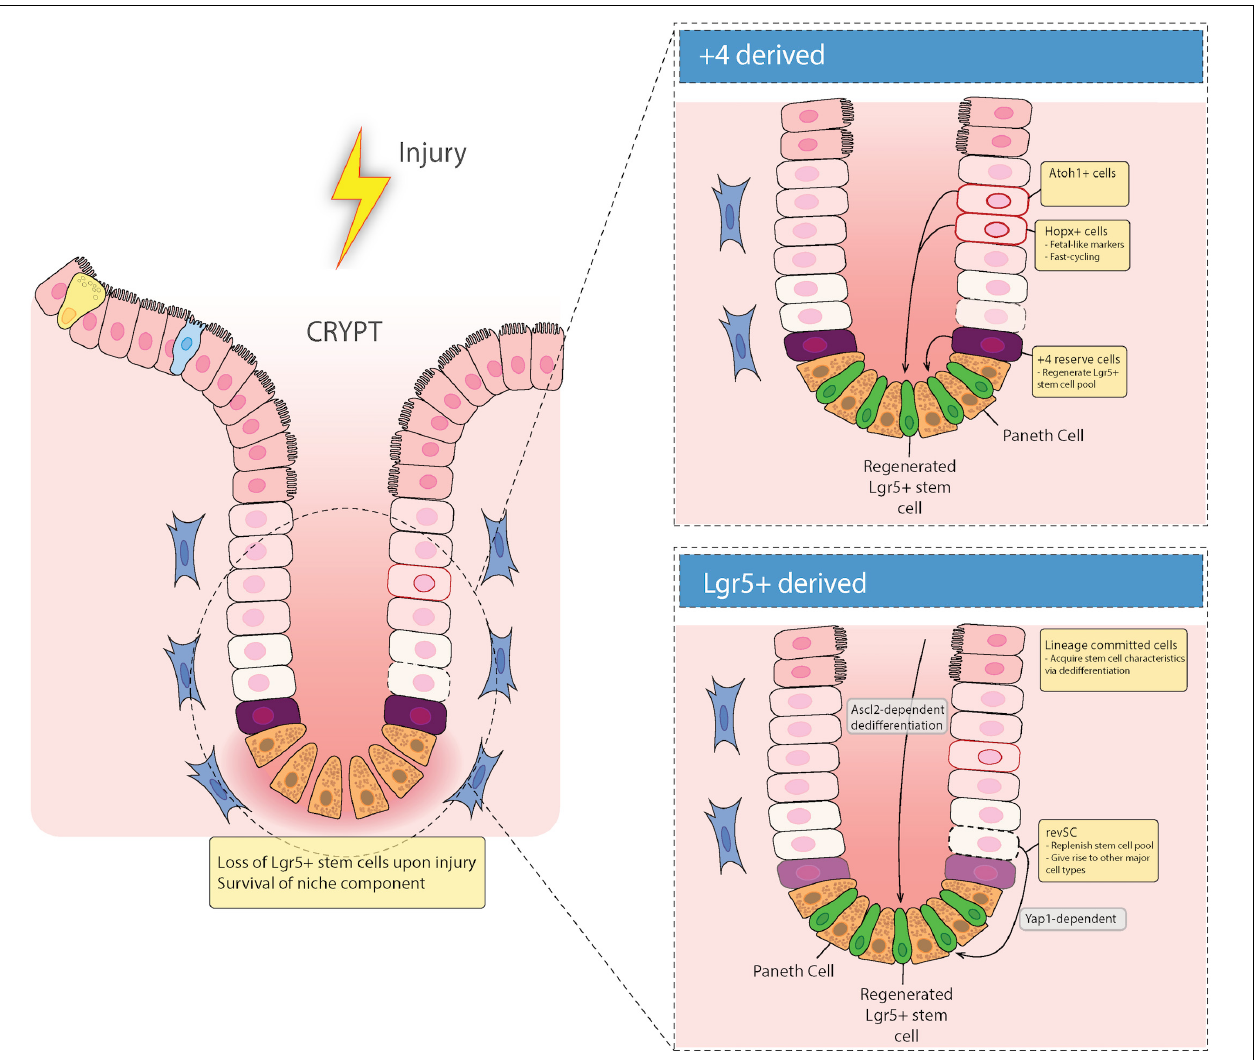
FIGURE 2 | Epithelial repair response to injury. Recent evidence has suggested that there are two types of regenerative cells that fill in the damaged epithelium after injury. When the intestinal epithelium is damaged, either acutely (e.g., via irradiation), or chronically (e.g., in inflammatory bowel diseases), there can be loss of Lgr5 + stem cells in the crypt base. These gaps in the epithelium are filled in with either Lgr5 + -derived reserve stem cells that can de-differentiate downward, or are +4 cell position-derived, including Hopx and/or Atoh1 expressing mature cell precursors that de-differentiate and migrate down from the TA zone to regenerate the stem cell